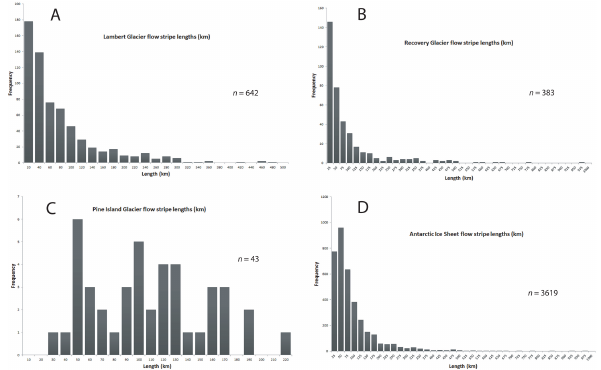
Figure 6. Histograms showing mapped flow stripe lengths for (a) the Lambert Glacier system, (b) Recovery Glacier, (c) Pine Island Glacier and (d) the entire Antarctic Ice Sheet. Note the variation in the frequency scale. The distribution is strongly positively skewed for the Lambert Glacier system, Recovery Glacier and the Antarctic Ice Sheet as a whole but not for Pine Island Glacier. Reasons for this are discussed in the